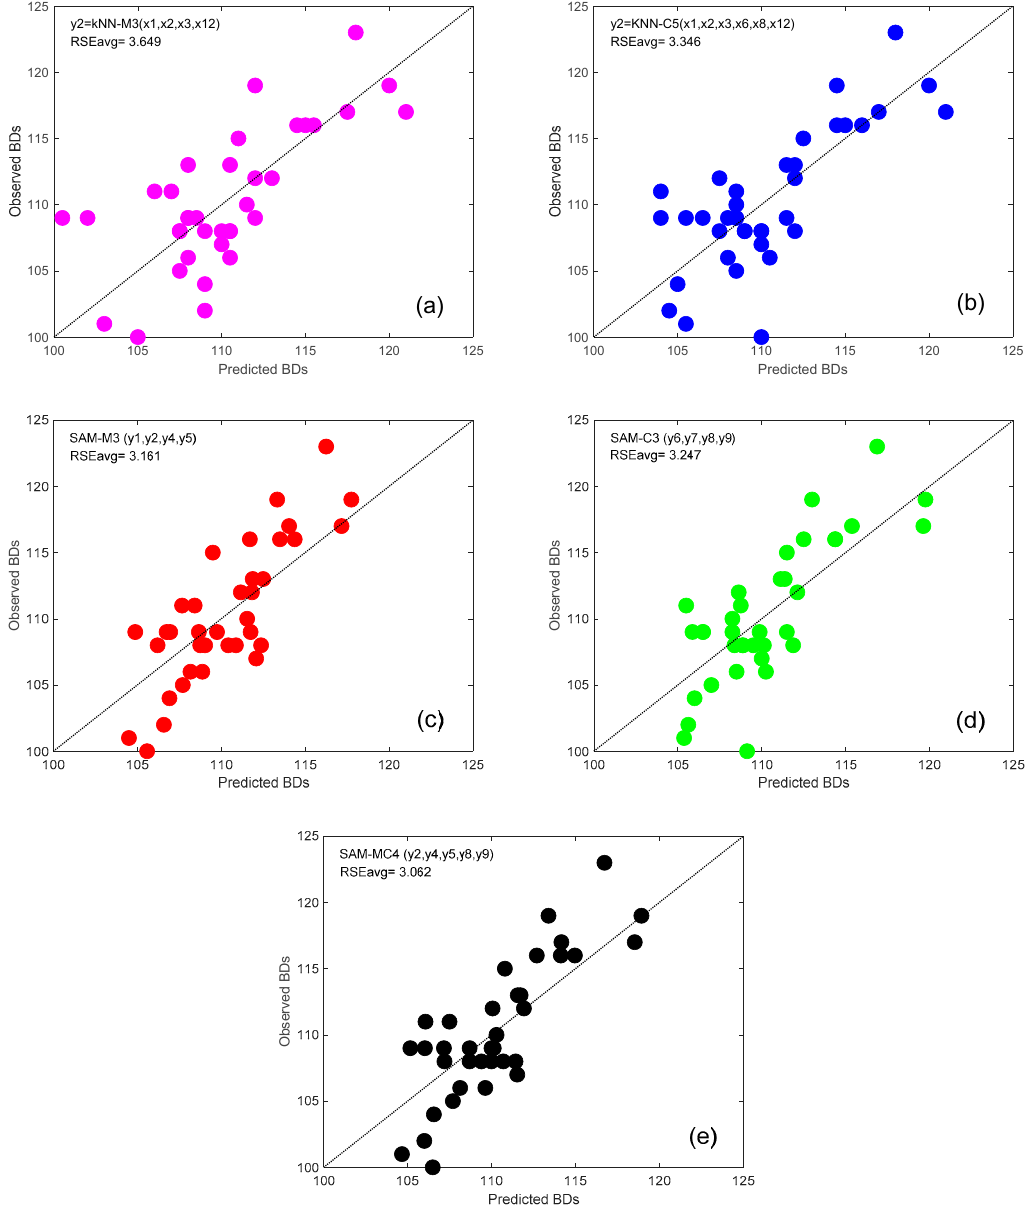
Figure 7. Validation performance of optimal base and ensemble kNN models. ( a ) kNN-M3. ( b ) KNN-C5. ( c ) SAM-M3. ( d ) SAM-C3. ( e ) SAM-MC4.